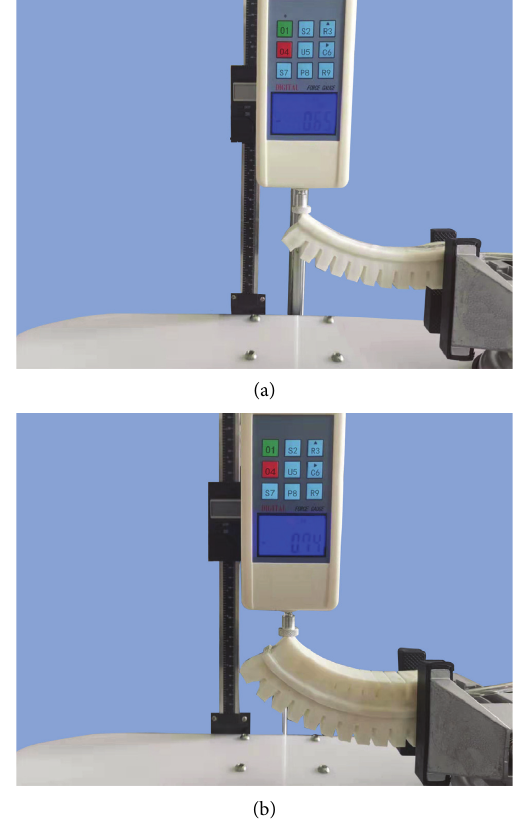
Figure 11: Torque measurement experiment of pneumatic soft- bodied bionic basic execution unit. (a) Unidirectional basic exe- cution unit. (b) Bidirectional basic execution